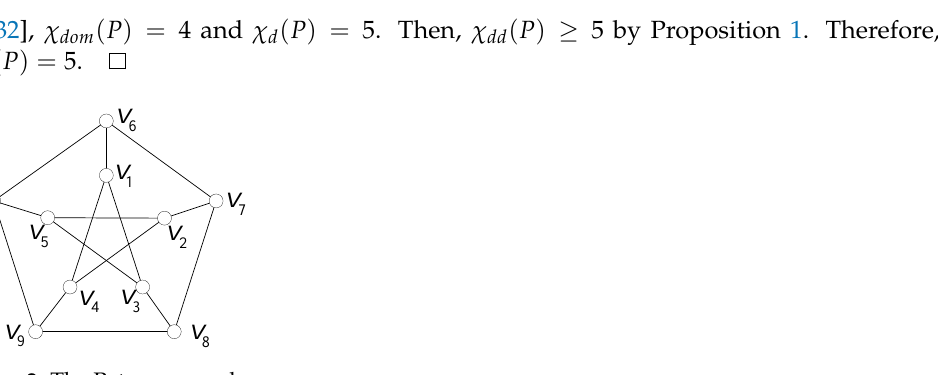
Figure 2. The Petersen graph.